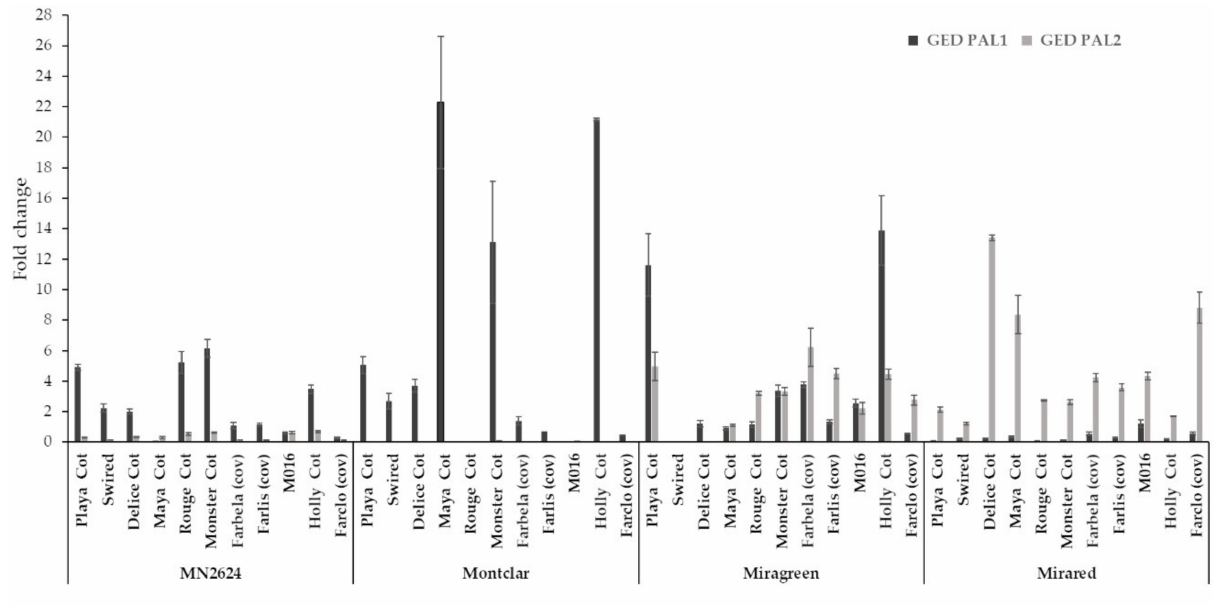
Figure 5. Expression profiles of PAL genes (PAL1 and PAL2) from 11 different apricot cultivars grafted on four different rootstocks (A‘MN2624’, ‘Montclar’, ‘Miragreen’, and ‘Mirared)’. Evaluating the effect of every combination three months after grafting. Values are the mean of three replicates ±